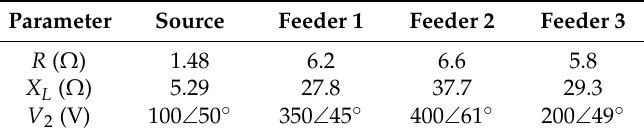
Table 1. Circuit parameters for the three-feeder system.